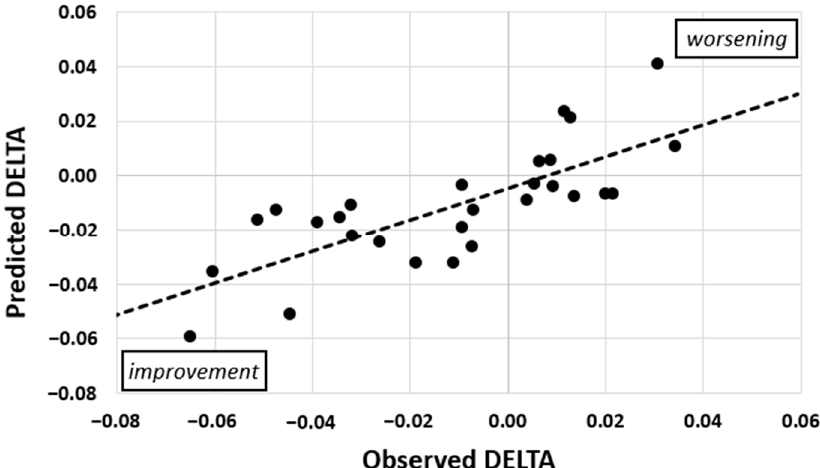
Figure 2. Predicted and observed daily changes in the WSS (DELTA) of 28 patients. The model had an R 2 adjusted of 0.48 ( p < 0.01) and five factors. Values below zero represent an improvement of the sensorimotor function over the course of rehabilitation. Table 2. Model of multiple linear regression for DELTA with an R 2 adjusted of 0.48 ( p < 0.01). STEPS REST EDSS TYPE PURSUIT β -weight